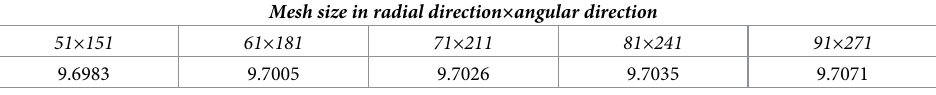
Table 3. Difference of Nu with alteration of mesh size at Ra = 10 5 , Rd = 0.8, Da = 100, Ha = 20 and ϕ = ave